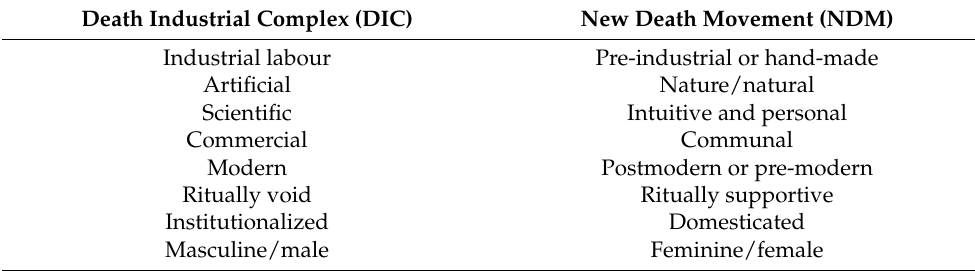
Table 1. The symbolic contrasts drawn between the Death Industrial Complex (DIC) and the New Death Movement (NDM) by members of the latter, as analysed by the authors. Death Industrial Complex (DIC) New Death Movement (NDM) Industrial labour Pre-industrial or hand-made Artificial Nature/natural Scientific Intuitive and personal Commercial Communal Modern Postmodern or pre-modern Ritually void Ritually supportive Institutionalized Domesticated Masculine/male Feminine/female Critiques of DIC’s motivations are not new nor exclusive to the NDM. Perhaps